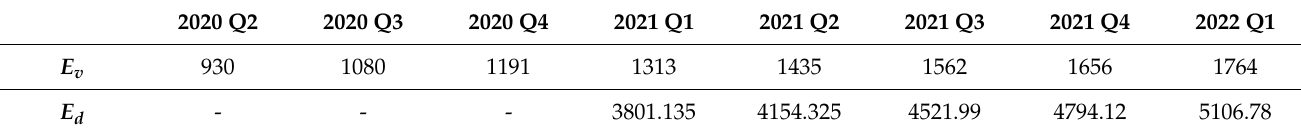
Table 11. The forecast of electricity consumption in County